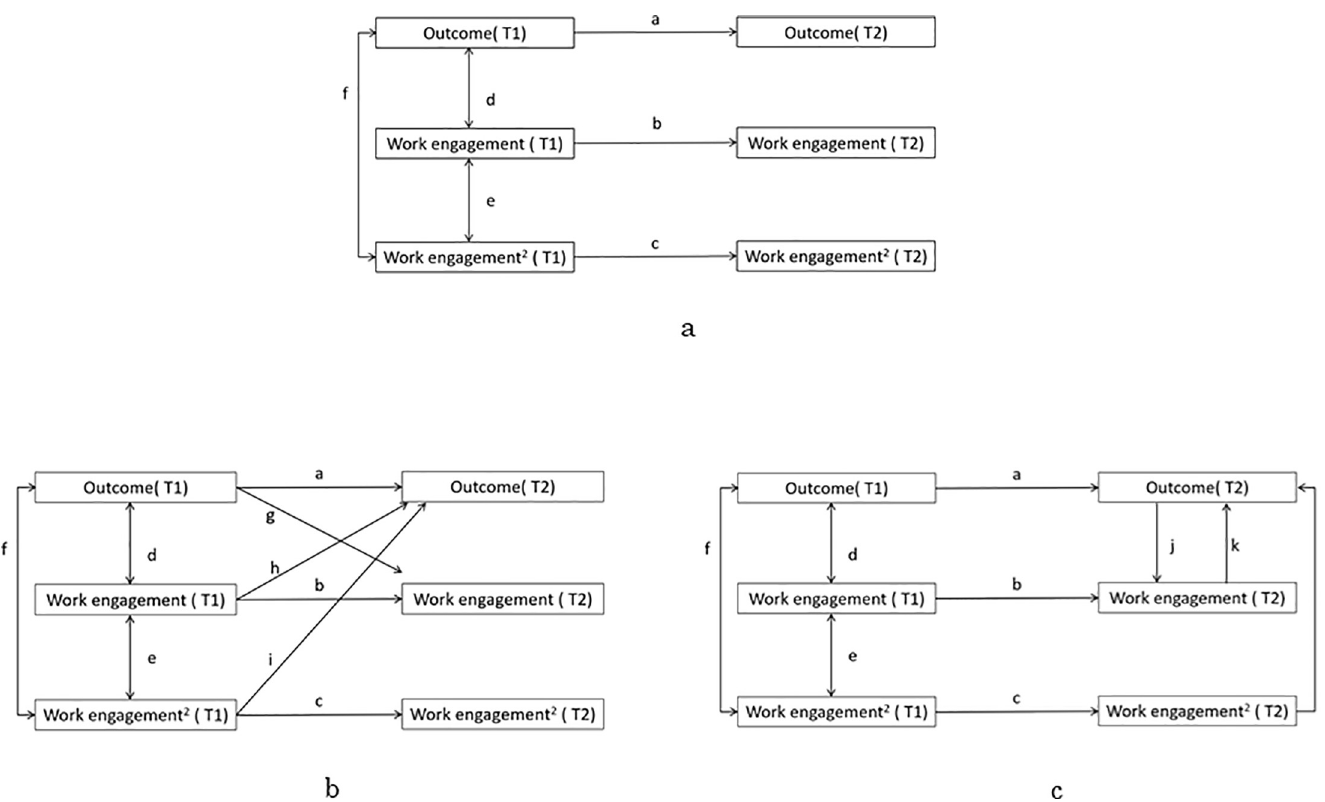
Fig 1. Models for testing longitudinal relations between work engagement and outcomes in stability model (Fig 1A), lagged model (Fig 1B), and concurrent model (Fig 1C). In Fig 1A, arrows a, b, c are the stability coefficients, and arrows d, e, f are the covariances at Time 1 (T1). In Fig 1B, arrow a, b, c are the stability coefficients, and arrows d, e, f are the covariance at Time 1 (T1); arrows g, h, and I are the cross-lagged coefficients. In Fig 1C, arrow a, b, c are the stability coefficients, and arrows d, e, f are the covariance at Time 1 (T1); arrows j, k, and l are concurrent coefficients at Time 2